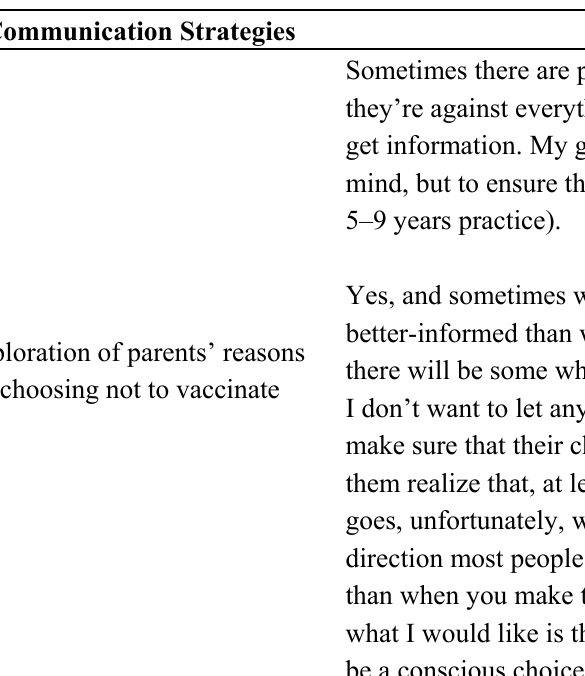
Table 4. Communication strategies used and reactions of midwives and physicians when faced with parents who refuse to vaccinate or who have significant doubts regarding